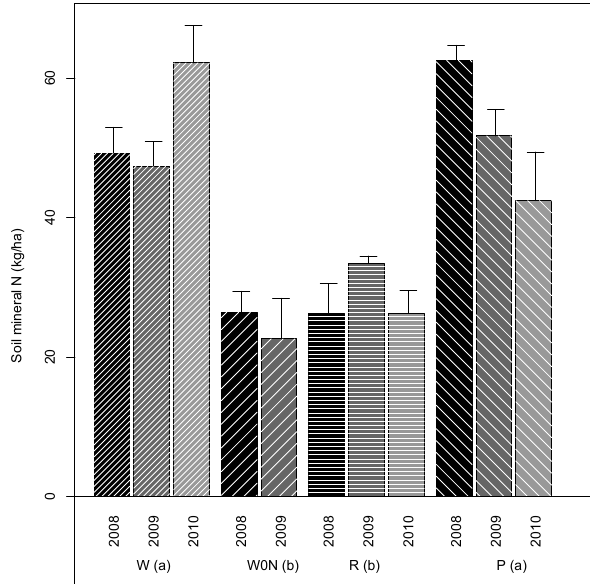
Figure 5. Soil mineral content (kg.ha -­‐1 ) after harvest in the whole soil profile according to the crop (which was just harvested: W= wheat, W0N= unfertilized wheat, R= rape, P= pea) and the year. Groups of bars with the same letter are not significantly different. Error bars: standard error of the mean.